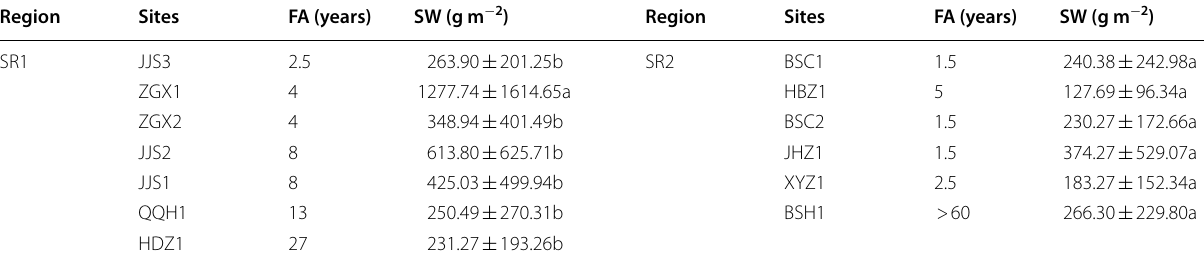
FA and SW represent formation age of RCSs and soil weight, respectively; SW data are expressed in mean lowercase letters represent the significantly different ( P < 0.05) in soil weight Table 4 The soil organic carbon, total nitrogen and total phosphorus contents at sampling sites